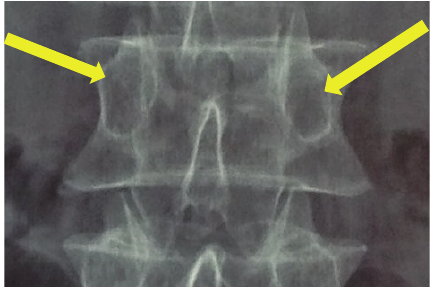
Figure3:Arrowsshowthepositionofthetipofthecannulaandalso needle trajectory on anteroposterior view, when the cannula came into contact with posterior elements of the